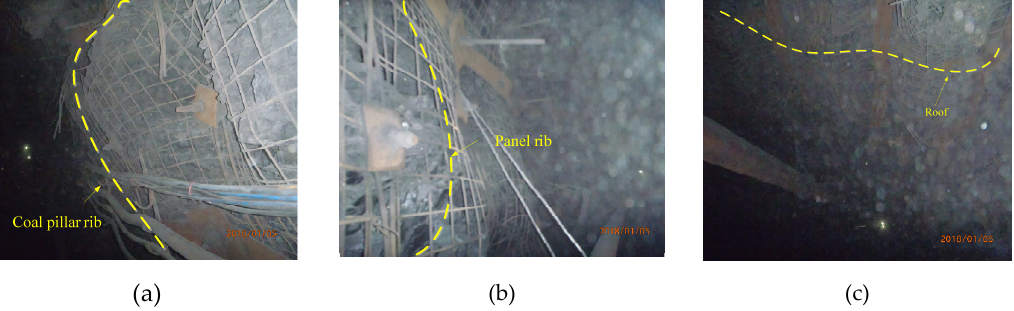
Figure 3. The deformation and failure of roadway surrounding rock. ( a ) Coal pillar rib; ( b ) Panel rib; ( c ) The roof